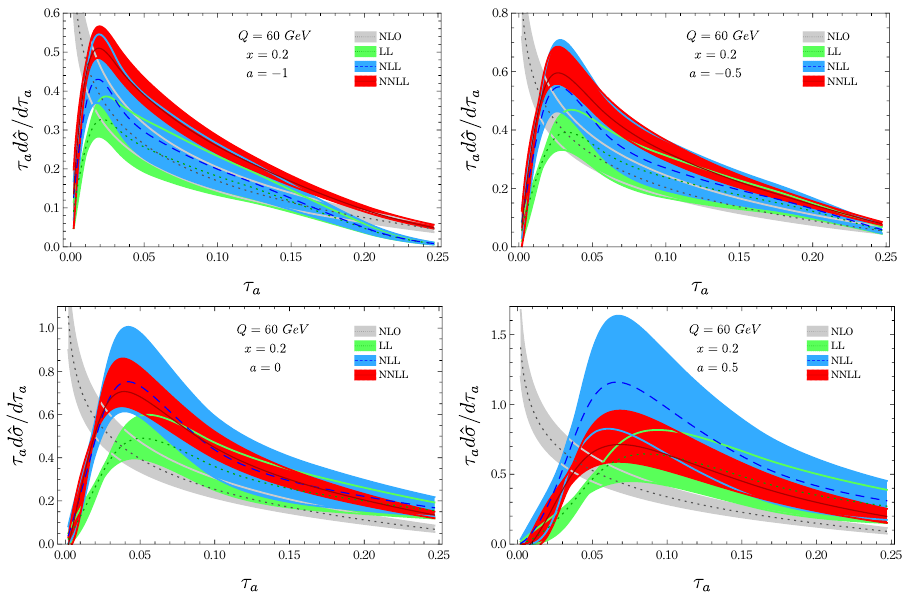
Figure 3 . Differential cross-section of DIS angularity τ a for different a = − 1 , − 0 . 5 , 0 , and 0 . 5 at a √ fixed x = 0 . 2 ( s = 140 GeV). The bands indicate perturbative uncertainties. √ √ s = 140 GeV as EIC plans to achieve s = 45 and 140 GeV [8, 9]. The coupling constant is taken as α ( m ) = 0 . 118 to have consistency to the central value of the s z